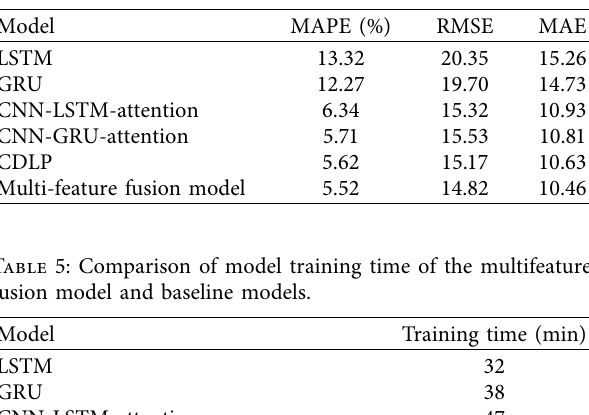
Figure 7: Comparison of MAPE results for different models. Table 4: Comparison of three evaluation indexes of the multi- feature fusion model and baseline models.